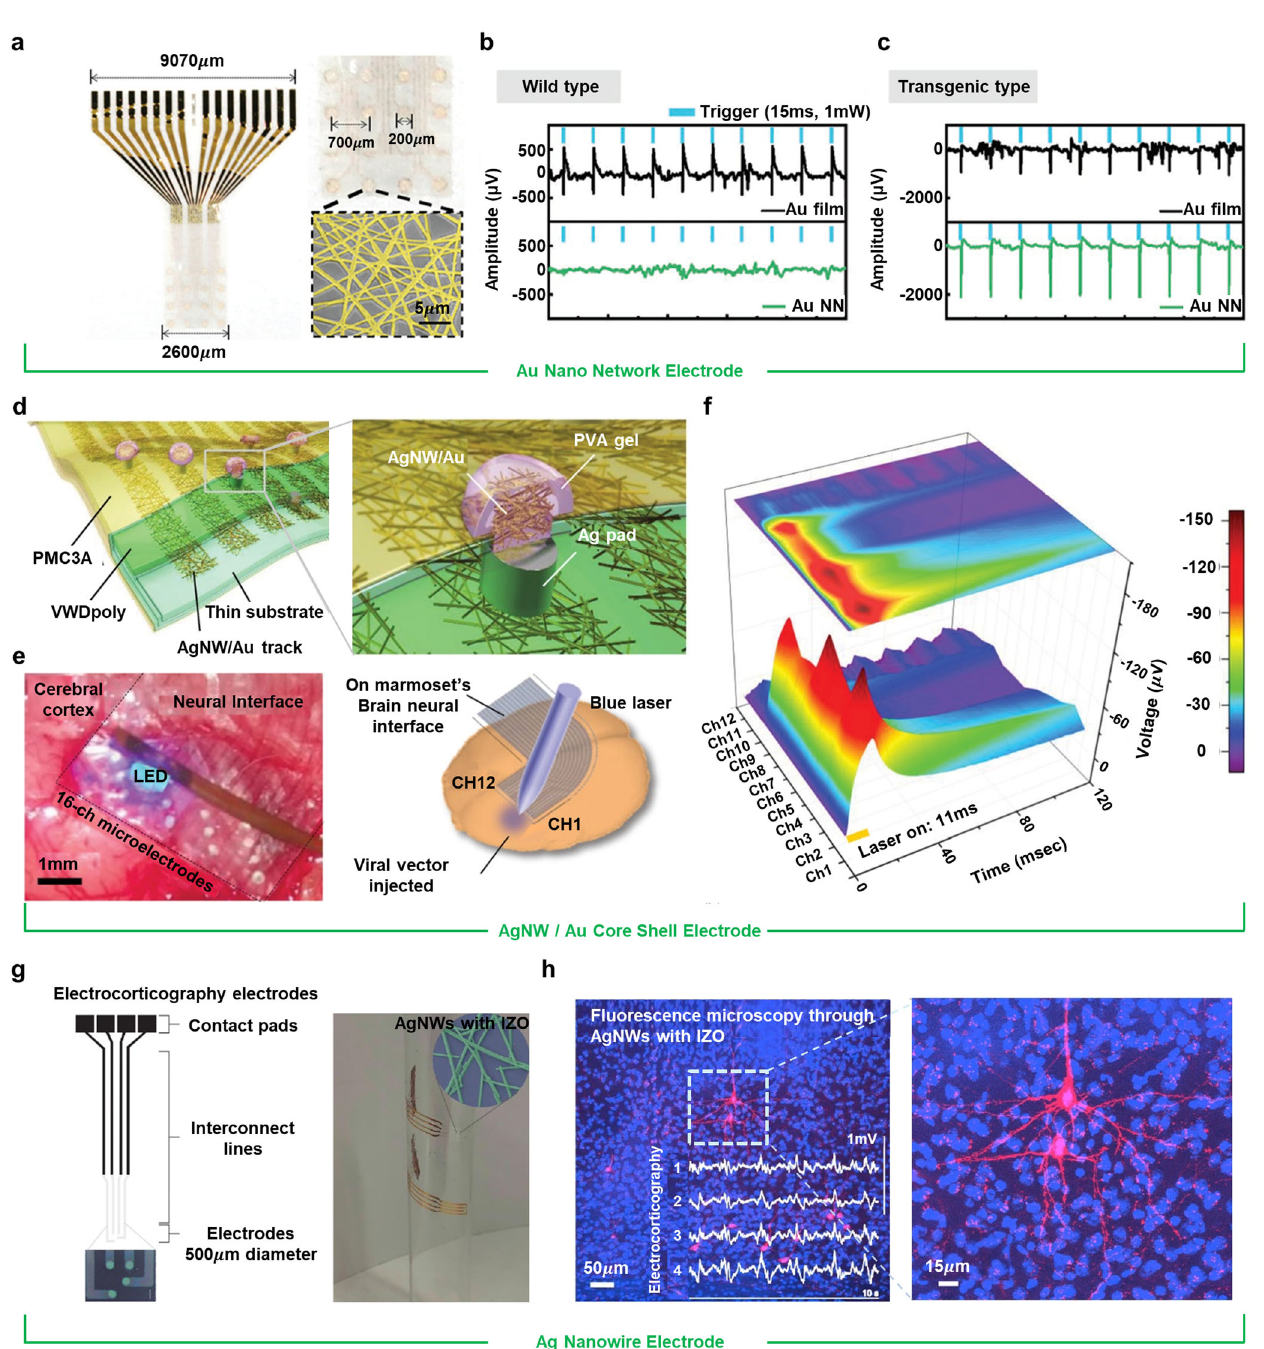
Fig. 7 Metallic nanowire-based transparent electrode arrays for multimodal sensing and stimulation of neuro-dynamics. a 16-channel Au- nano network (NN) microelectrodes array for electrocorticography (ECoG) recording. b, c in vivo evaluation of an artifact-free ECoG recording with gold (Au) fi lm (opaque) and Au-NN (transparent) microelectrode arrays with optical stimulation of the cerebral cortex of wild type b and transgenic type (B6 Thy1-ChR2-YFP) mice c . d Schematic illustration of a multifunctional neural interface integrated with a silver (Ag)/Au core- shell nanowire (Ag nanowire (NW)/Au) with poly vinyl alcohol (PVA) gel-coated microelectrodes. e 16-channel AgNW/Au microelectrodes conformally contacted on cerebral cortex including light emitting diode (LED) (left), and the optogenetics in vivo setup of 12-channel AgNW/ Au microelectrodes on marmoset brain (right). f 3D graph of the ECoG signal over time, induced by optical stimulation. g Schematic design of transparent ECoG electrode arrays based on AgNW with indium zinc oxide (IZO). h Visualization of neurons with fl uorescence microscopy and ECoG recordings through AgNW/IZO microelectrodes of the cortex of mice under urethane anesthesia. Panels a, b, and c reprinted with permission from ref. 18 , Wiley; panels d, e, and f reprinted with permission from ref. 22 , Wiley; panels g and h reprinted with permission from ref. 179 ,